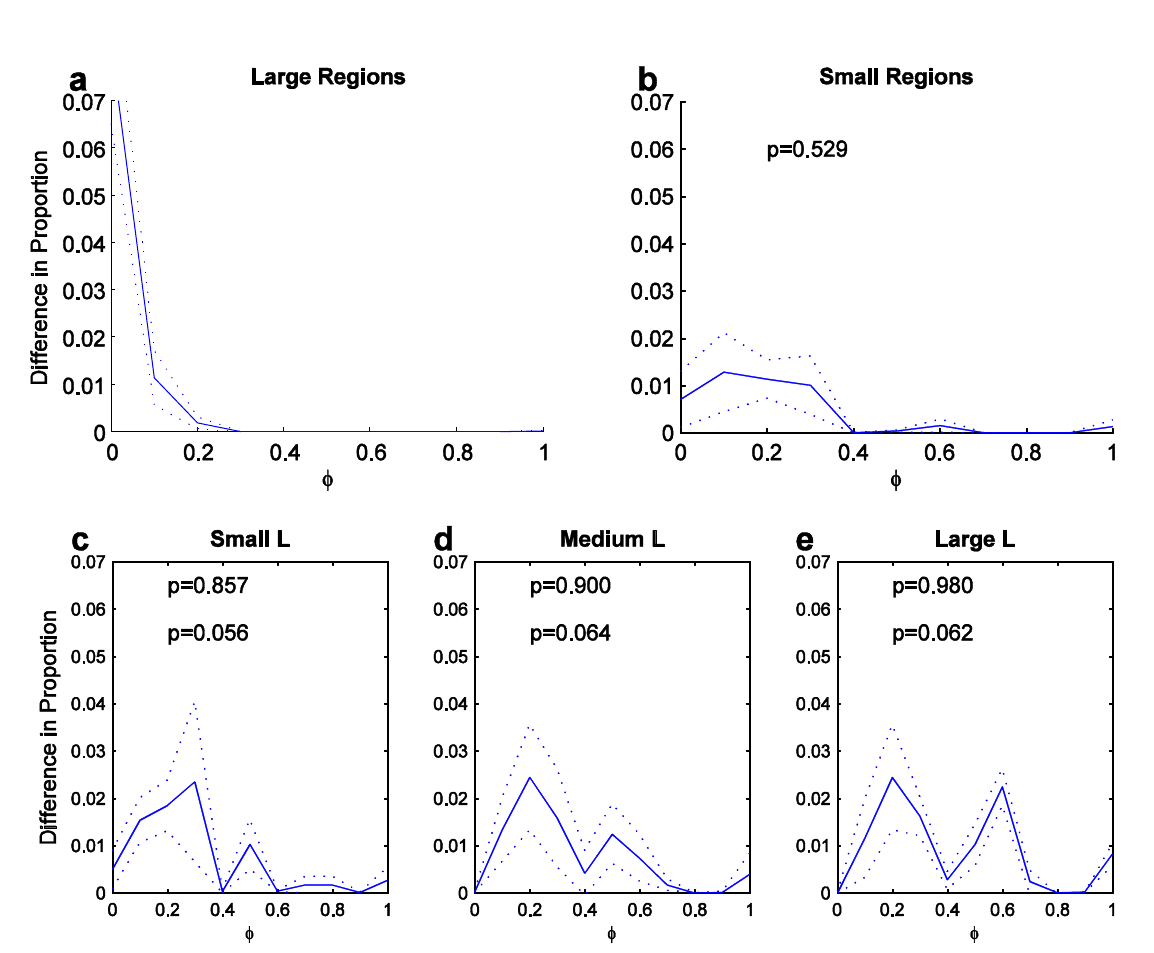
Figure 4. Latitude preference distributions (averaged across scales; dotted curves outline width of standard deviation). X-axis as in Figure 3 top plot. a. Large regions. b. Small regions. c-e. Preference for L features for three angle bandwidths (small [0, 17], medium [18, 45] and large [46, 135] angles; unit in degrees). Top p-value: t-test with distribution in a; Bottom p-value: t-test with distribution in